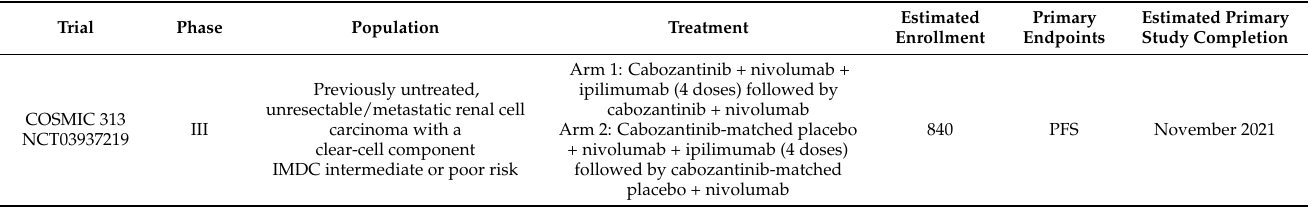
Table 3. Trial in progress for combination immune checkpoint inhibitor and anti-angiogenic therapies in advanced-stage clear-cell renal cell carcinoma, as obtained from